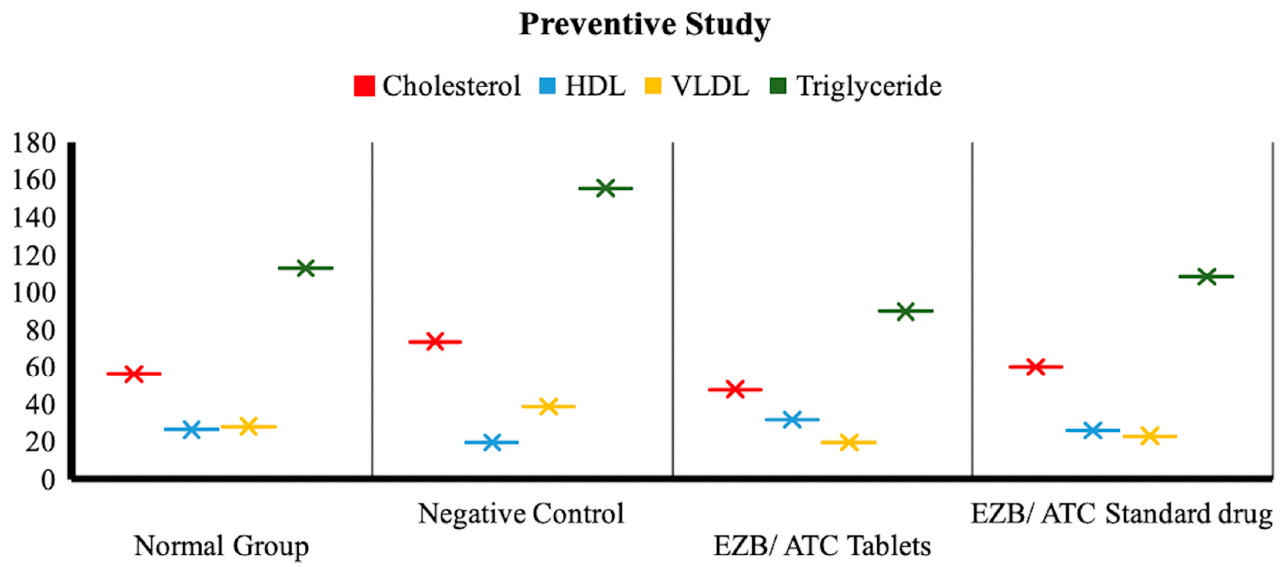
Figure 6. The effects of drugs on cholesterol, HDL, VLDL and triglycerides during preventive treat- ment in normal group, negative control, EZB/ATC tablet group and EZB/ATC standard drug group. Lipid Profile in Negative Control Group vs. Treated Groups